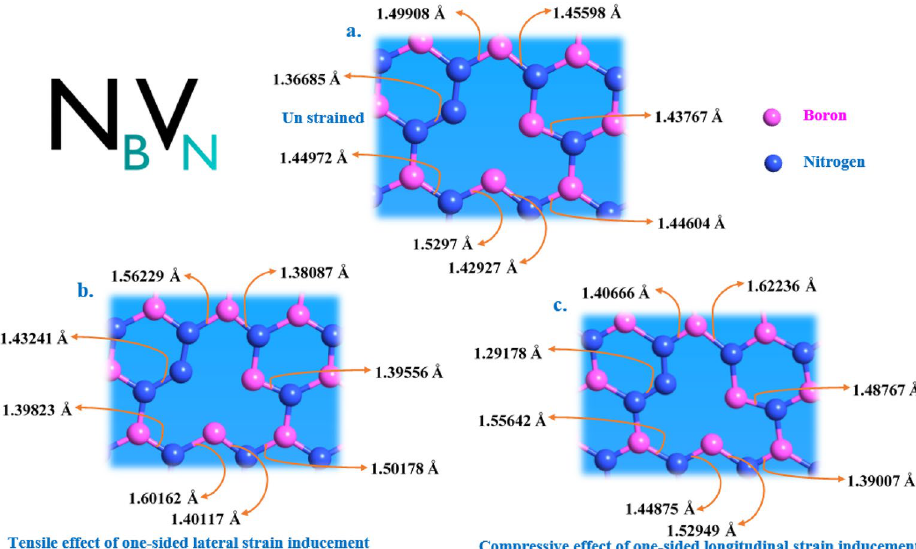
Figure 14. Schematic representation of bond length alters in N B V N defect due to one-sided lateral and longitudinal strain inducement. ( a ) Optimized N B V N point defect and their corresponding bond lengths measured under no external inducement condition. ( b , c ) N B V N point defect and their altered bond lengths measured under tensile effect of one-sided lateral strain and compressive effect of one-sided longitudinal strain inducements. Some of the bond lengths tends to increase and some of the bond lengths tends to decrease in both one-sided lateral and longitudinal strain inducements. This is due to the involvement of Poisson’s ratio effect along with one-sided lateral and longitudinal strain inducements. The % of positive and negative strain applied to the N B V N defect was listed in Table